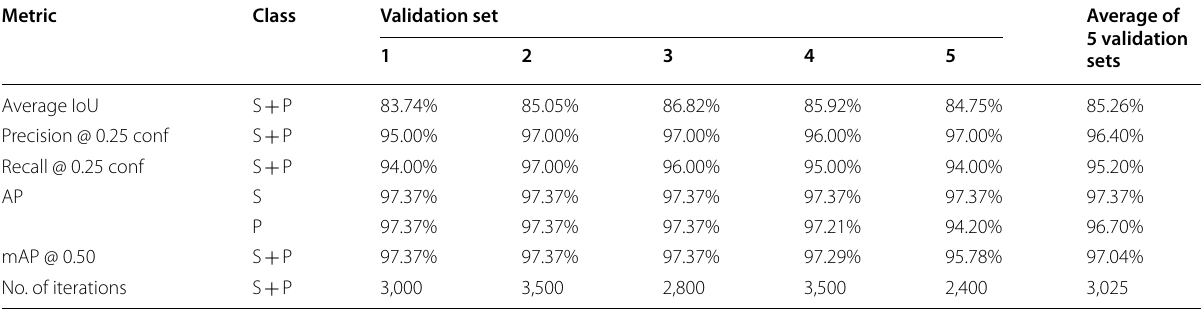
Table 1 The highest average performance of the trained model on five validation sets using fivefold cross validation (S: Stop sign; P: sign pole; S P: stop sign and sign pole) + Metric Class Validation